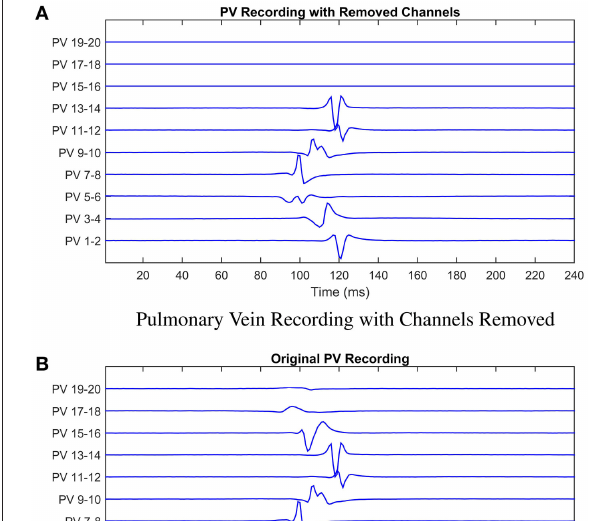
TABLE 2 | Effect of signal reconstruction on clinical